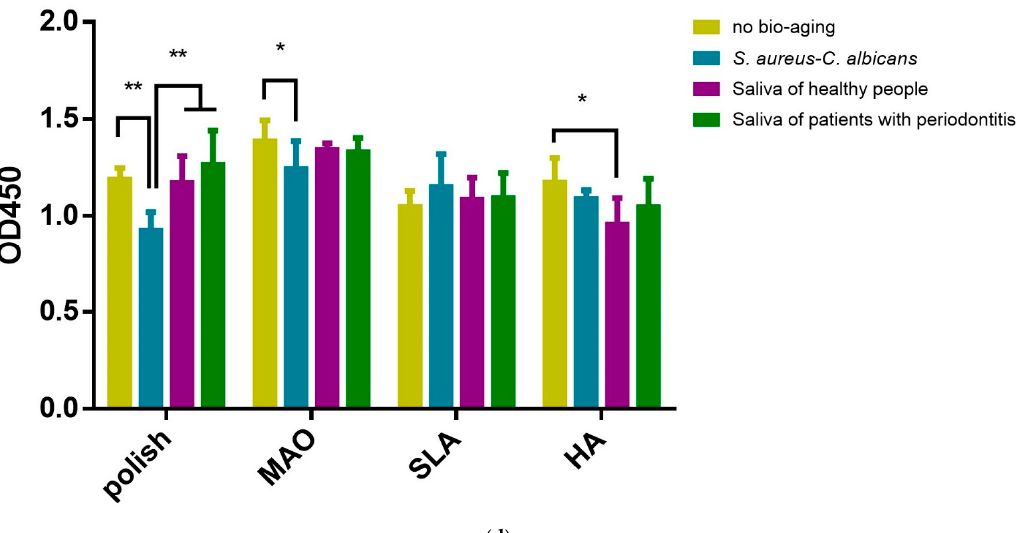
Figure 4. ( a ) and ( b ) The adhesion of HGFs was measured by laser confocal microscopy at 24 h and 48 h, respectively; ( c ) and ( d ) The metabolic activity of HGFs was measured by a CCK-8 test at 24 h and 48 h, respectively. n = 5 (* p < 0.05, ** p < 0.01).